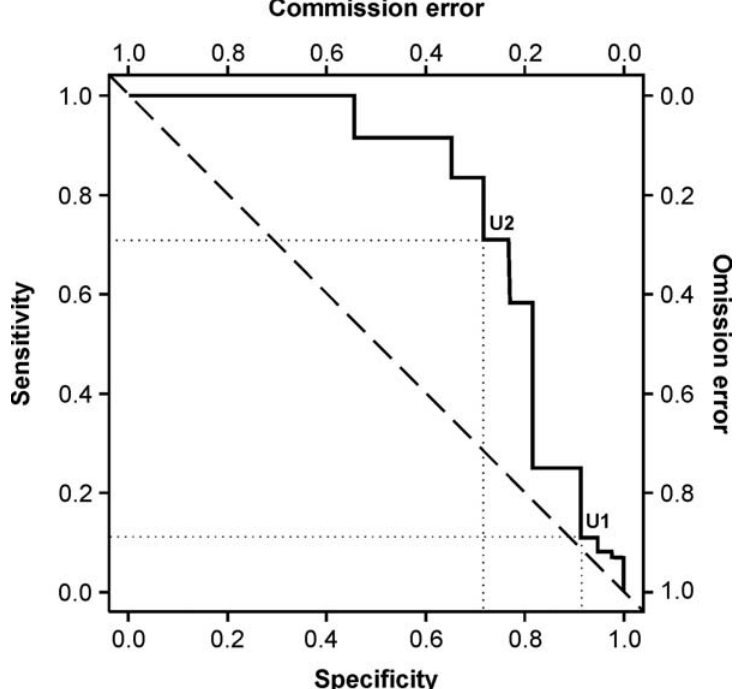
Figure 7. ROC curve for classification of mangrove areas. The diagonal dashed line represents a model with no predictive ability. Greater deviation of the ROC curve from this diagonal indicates greater discriminatory capacity of the model. U1 and U2 indicate the classification thresholds selected for assessment of mangrove and non-mangrove areas, respectively.